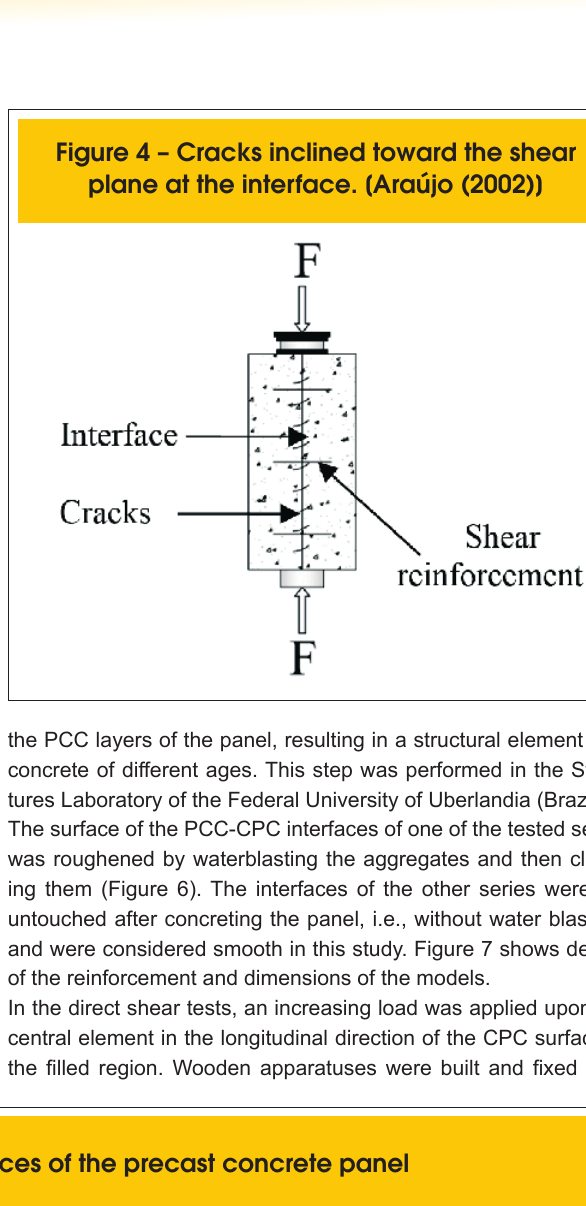
Figure 5 – Molding of the outer surfaces of the precast concrete panel